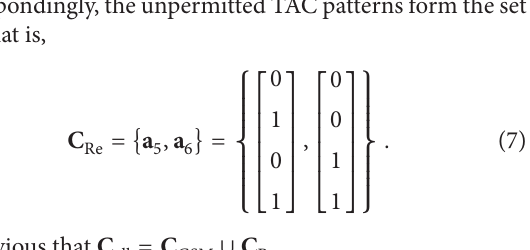
inverted searching tree are illegitimate. Hence, the direct